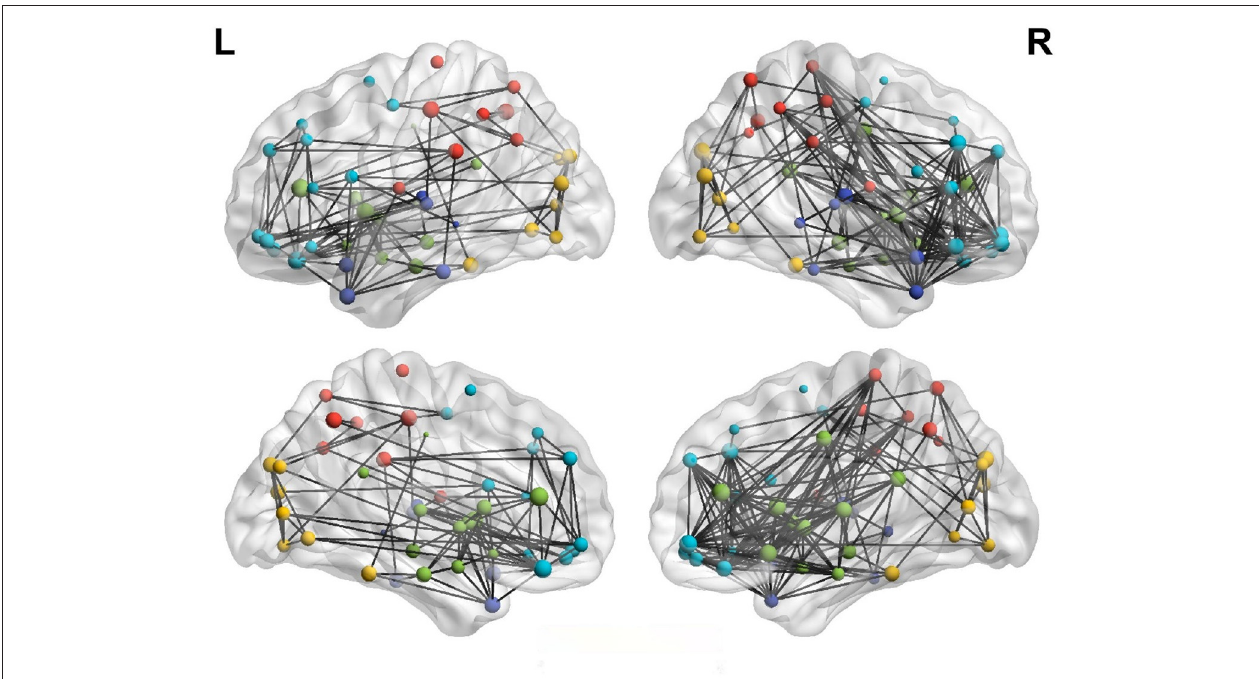
FIGURE 4 | Lateral hemispheric connectivity in patients with anti-NMDAR encephalitis. Pearson correlation coefficient R > 0.5 was the effective connection threshold, and the connection map of cerebral hemispheres was visualized in 3D view. (Dark blue is in the temporal lobe, light blue is the frontal lobe, red is the parietal lobe, yellow is the occipital lobe, and green is the limbic system).